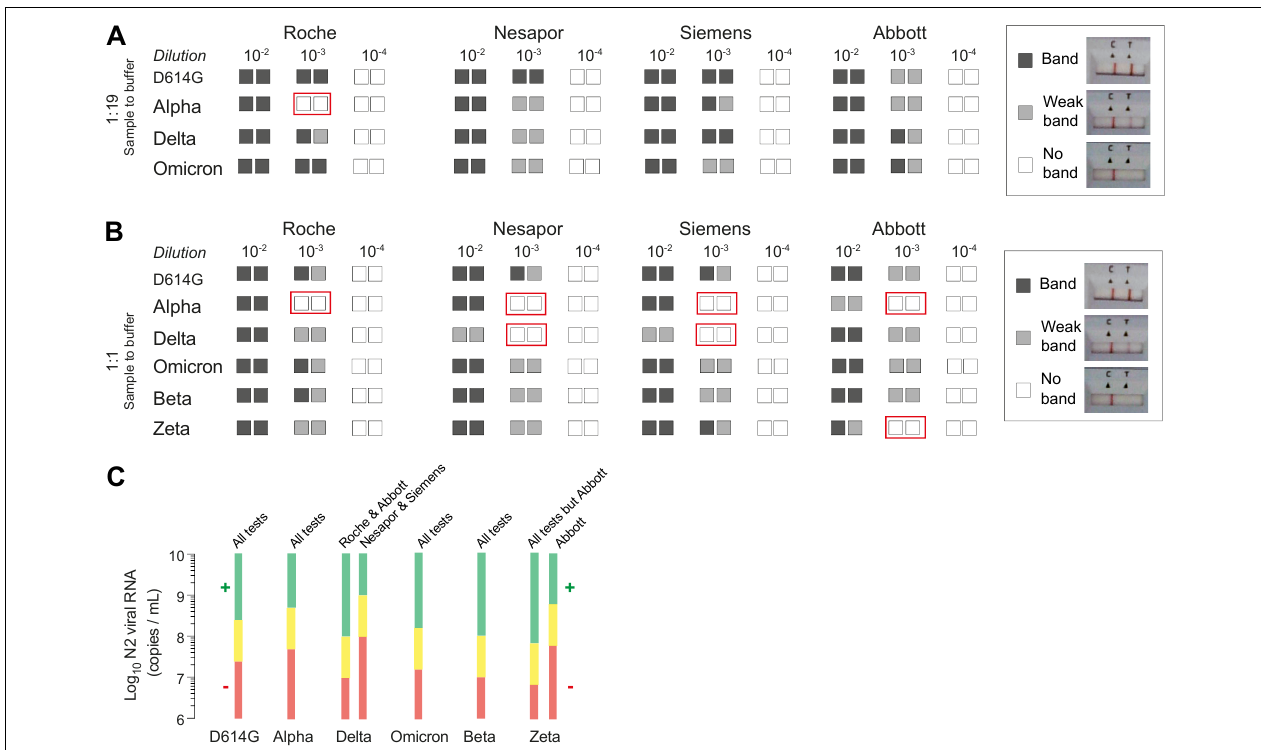
FIGURE 2 | Comparative detection of SARS-CoV-2 variants by four commercial Ag-RDTs and correlation with nucleocapsid copies per ml. (A) Detection of 4 VOC using a 1:19 ratio of sample-to-buffer volume (10 µ l:190 µ l). (B) Detection of six variants using a 1:1 ratio of sample-to-buffer volume (100 µ l:100 µ l). The results for 1/10 viral dilutions tested in duplicate are indicated for each variant and commercial Ag-RDTs. Red boxes indicate variant-Ag-RDTs combination with reduced detection capacity as compared to D614G. (C) The detection range shown as values of the viral N2 RNA (in log 10 of copies/ml). The range above the first 10-fold dilution with positive results of detection is shown in green, while the range below the first 10-fold dilution with negative results is depicted in red for each Ag-RDTs and every variant at the ratio